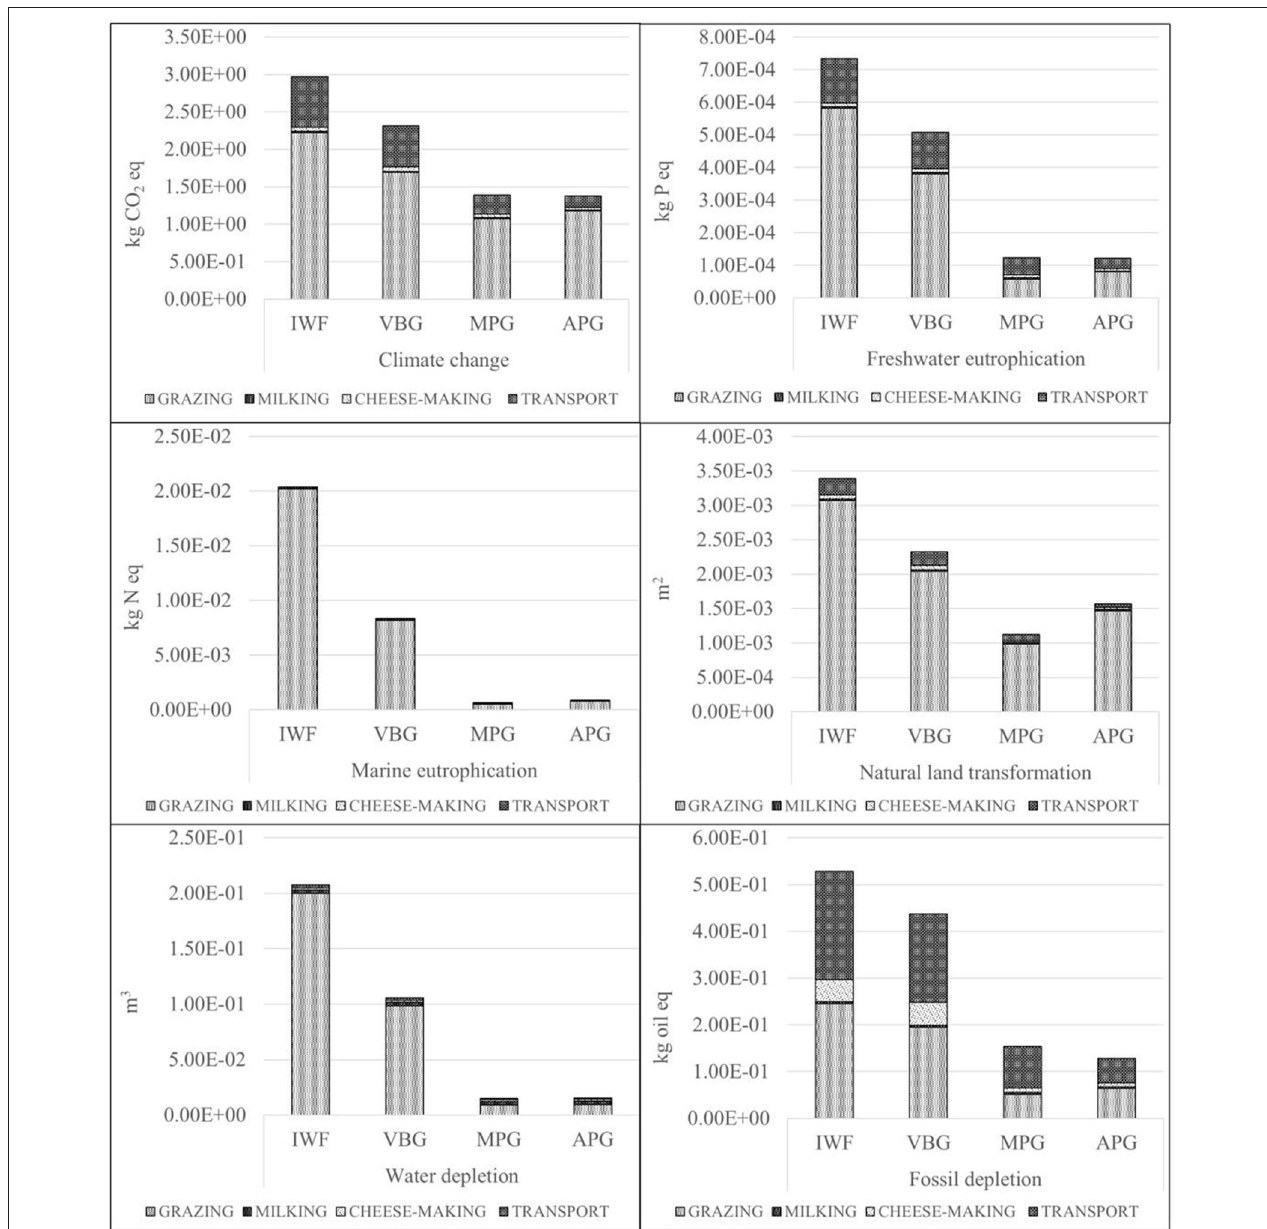
FIGURE 3 | Environmental